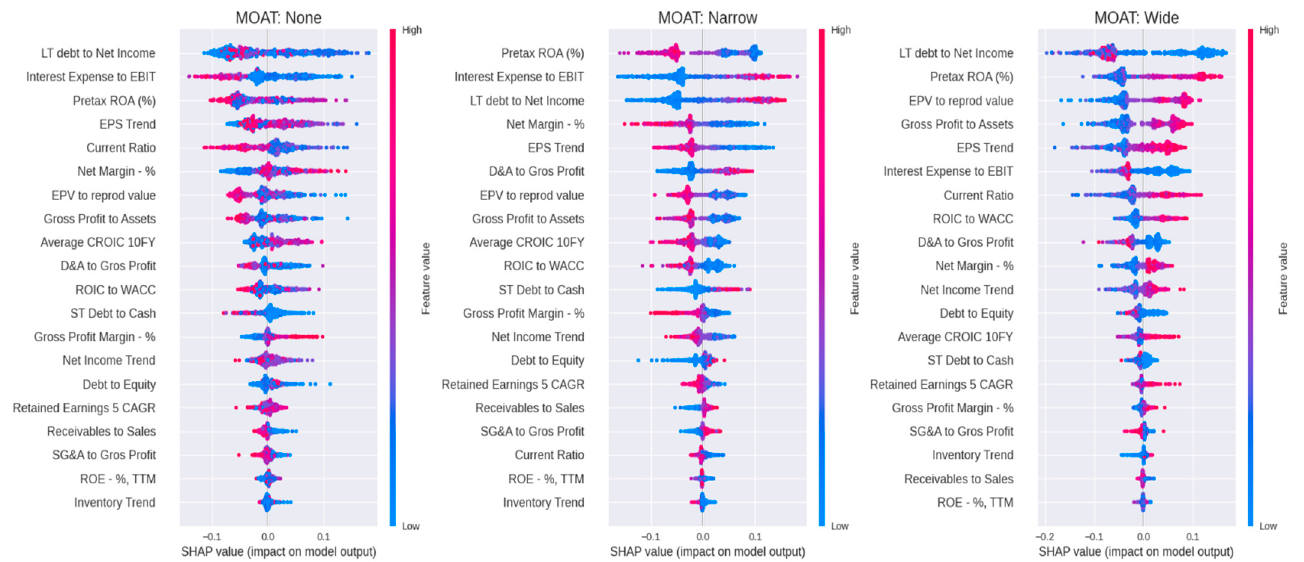
Figure 5. Importance of the features of each moat.